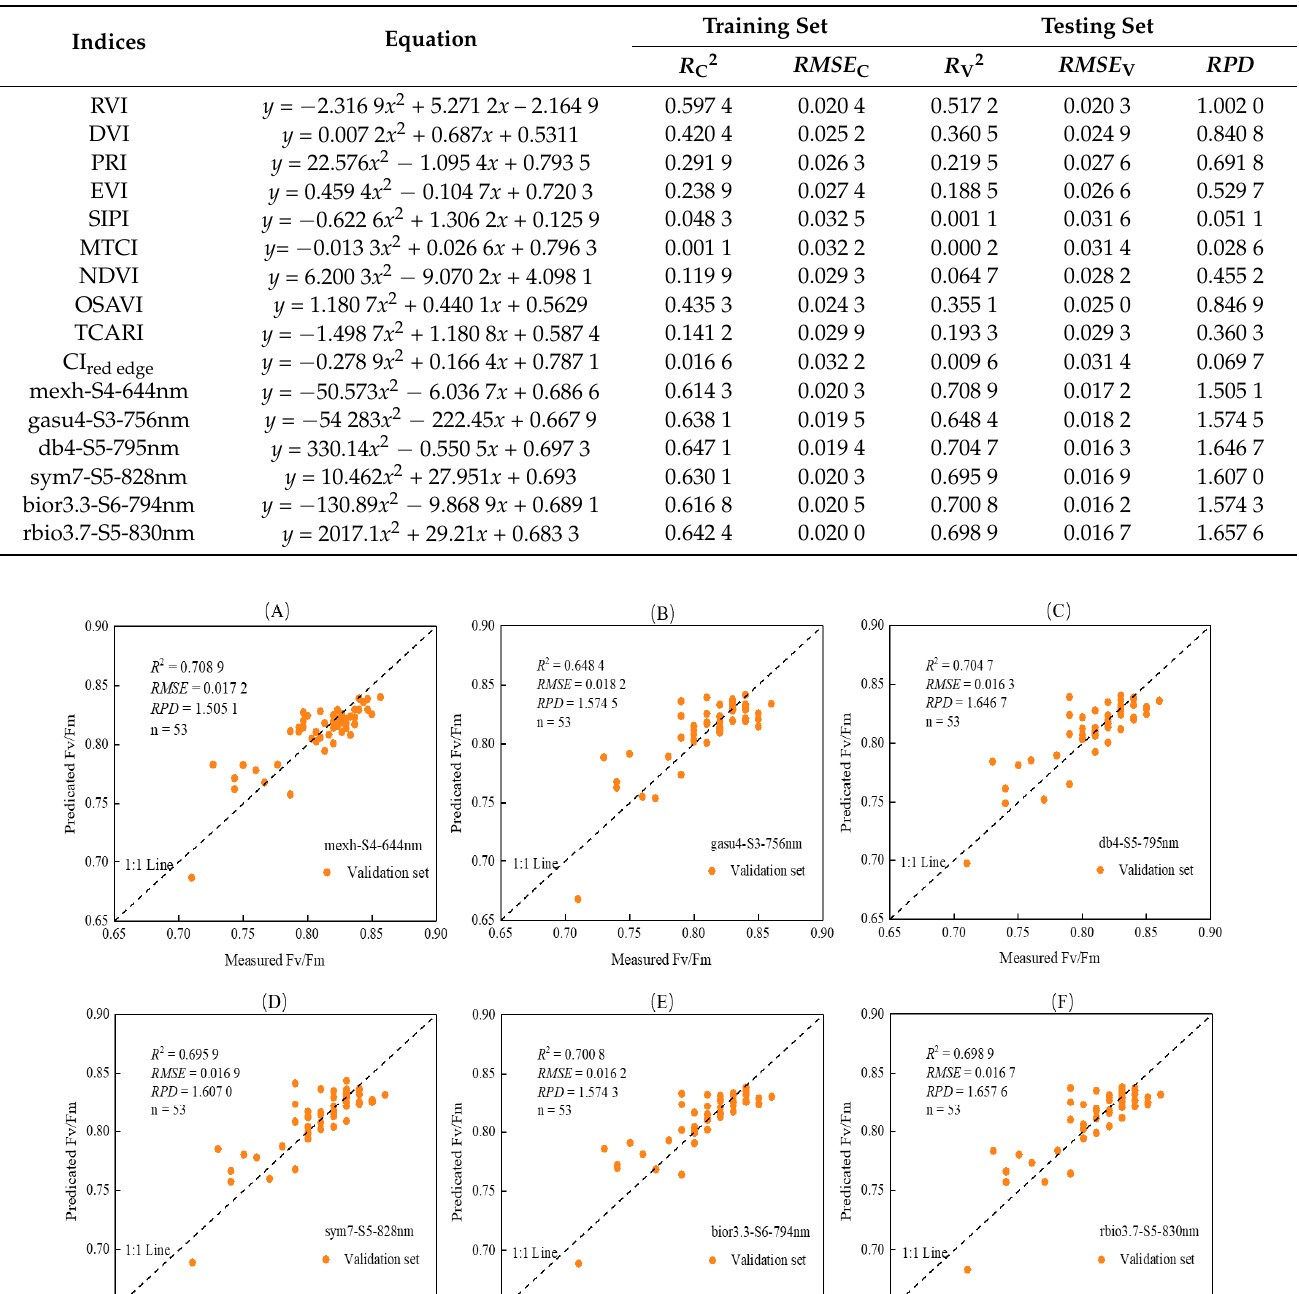
Table 5. Performance of models for estimating Fv/Fm based on VIs and wavelet features.